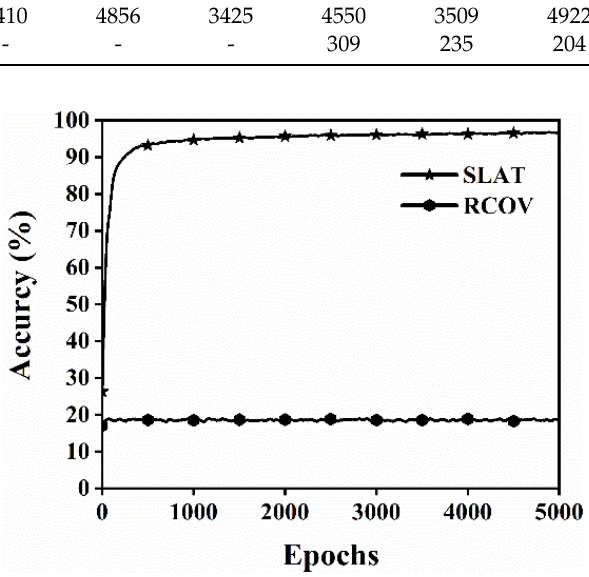
Figure 8. Accuracy comparison between RCOV and SLAT.